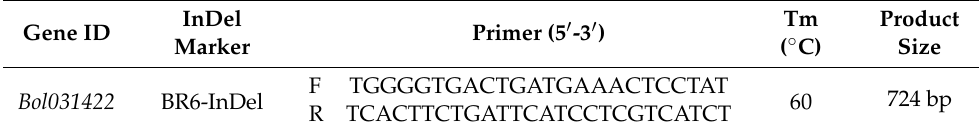
Figure 3. Sequence alignment between resistant (SCNU-C-3470, upper) and susceptible (SCNU-C-3328, lower) cabbage lines and position of InDel marker. The yellow and blue highlights in the alignment of DNA sequences indicate SNP and InDel, respectively. Table 2. Primer specifications of InDel marker associated with Xcc resistance in